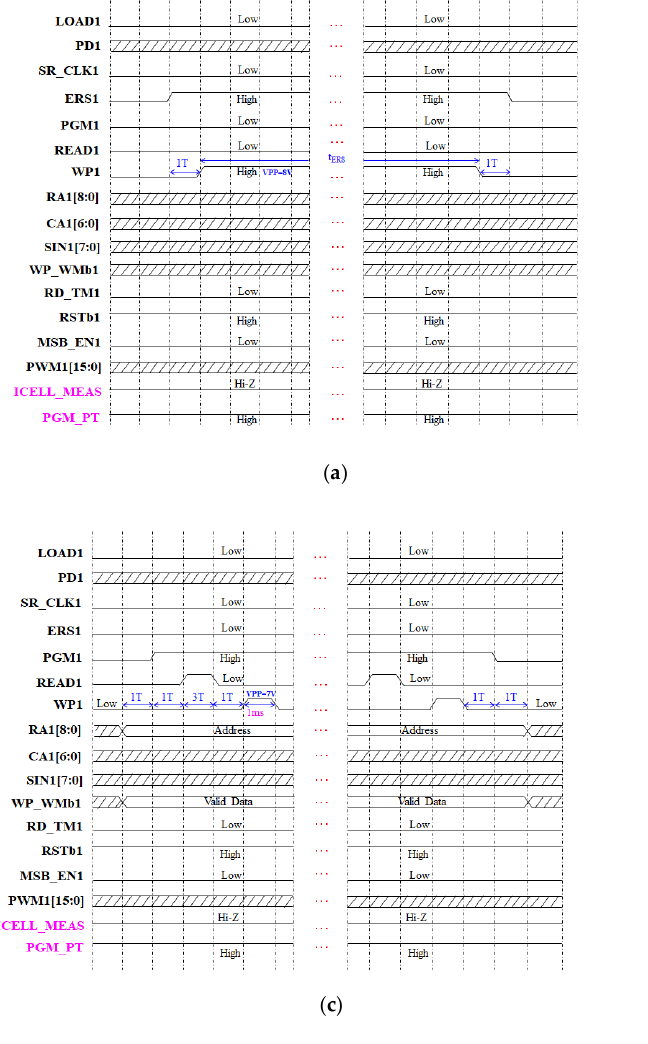
Figure 5. Timing diagram for erase, page buffer data load, program and read mode for the synapse driving circuit: ( a ) erase mode; ( b ) page buffer data load; ( c ) program mode; ( d ) read mode.